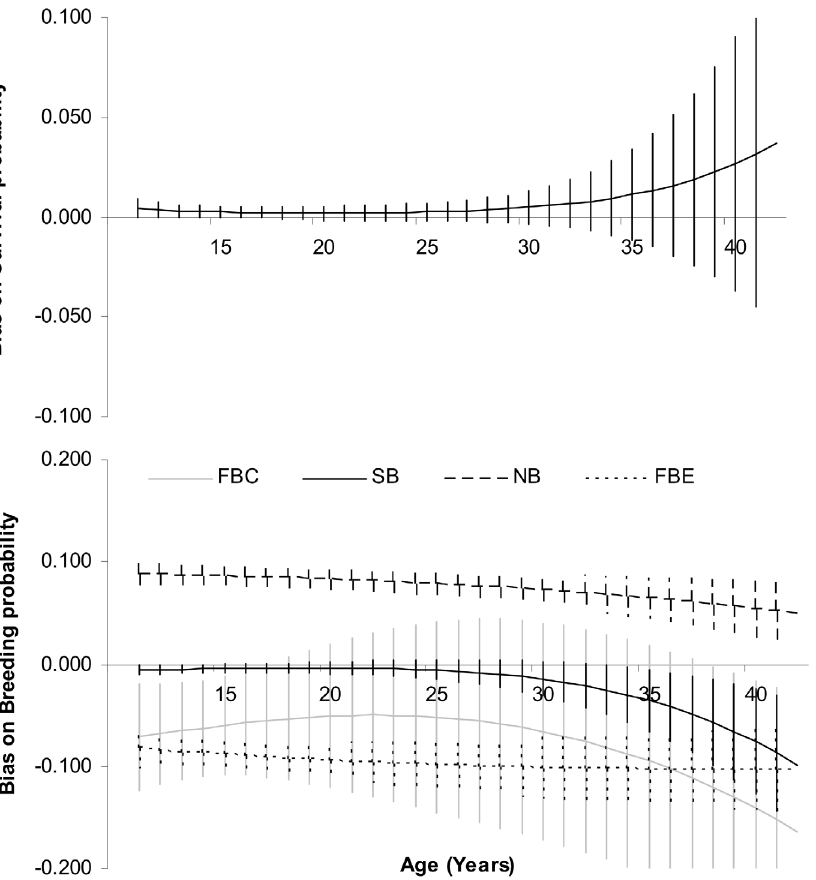
Figure 2. Age-dependent bias differences between models including Observable Non-Breeders or not, for survival and breeding probabilities ( ± SE) according to four previous breeding states: FBE=Failed Breeder on Egg, FBC=Failed Breeder on Chick, SB=Successful Breeder and NB=Non-Breeders.